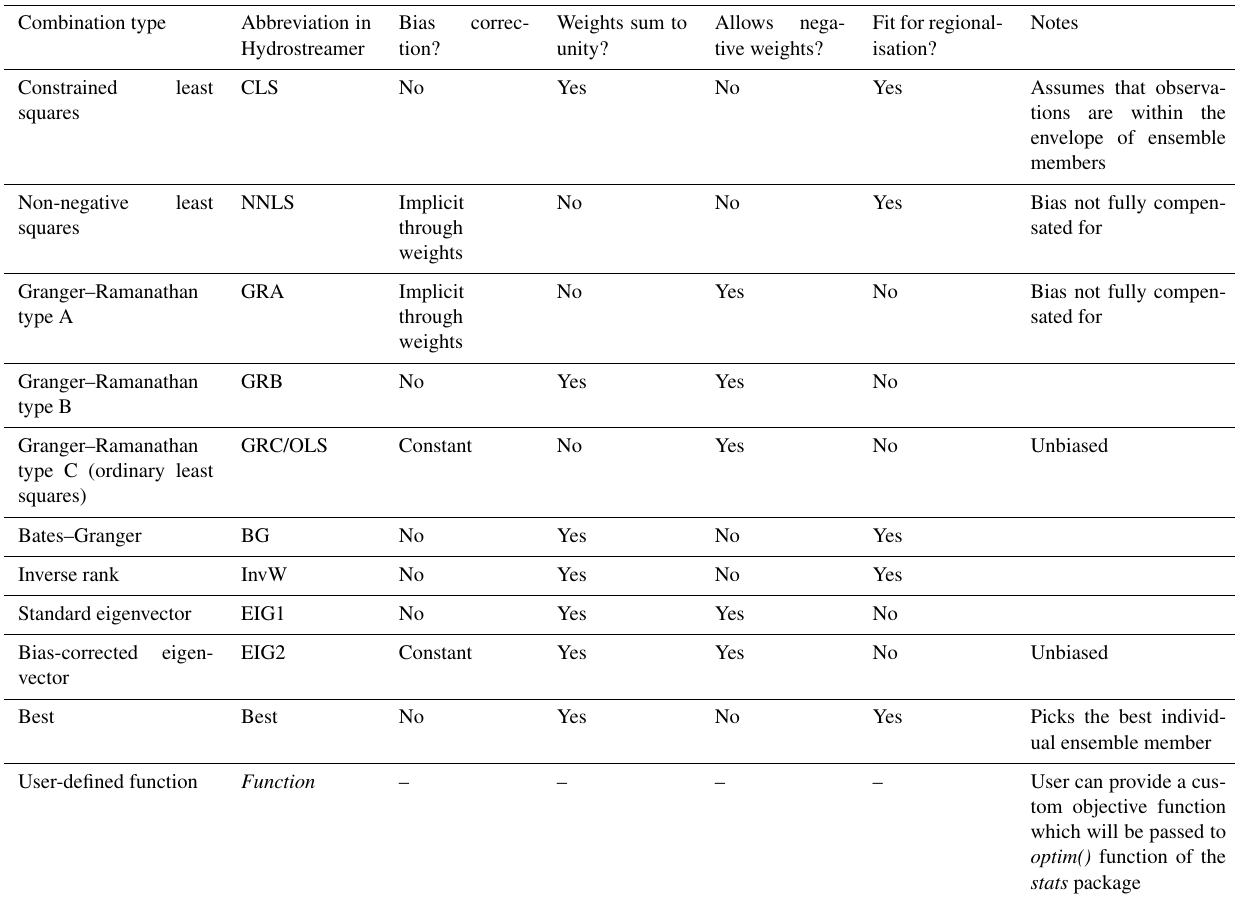
Table 1. Multi-model combination options implemented in Hydrostreamer